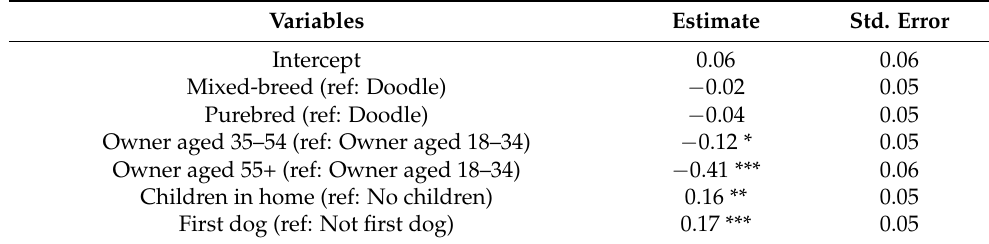
Table 4. The beta estimate and standard error for each factor in the general linear model examining the relationship between breed type, owner age, the presence of children in the home, whether this was the owner’s first dog, and owner-reported dog behavior. Variables Estimate Std. Error